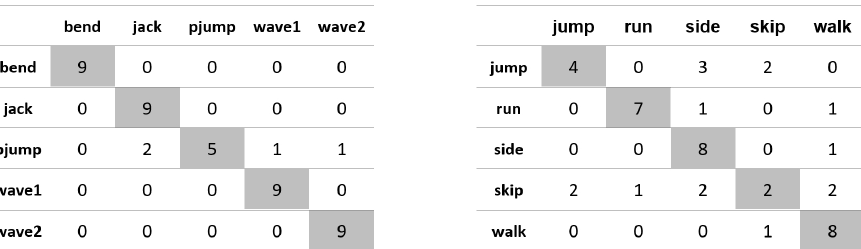
Figure A10. Confusion matrices for the experiment using the ‘lower-occlusion’ database, rectangu- larity and C1 correlation.